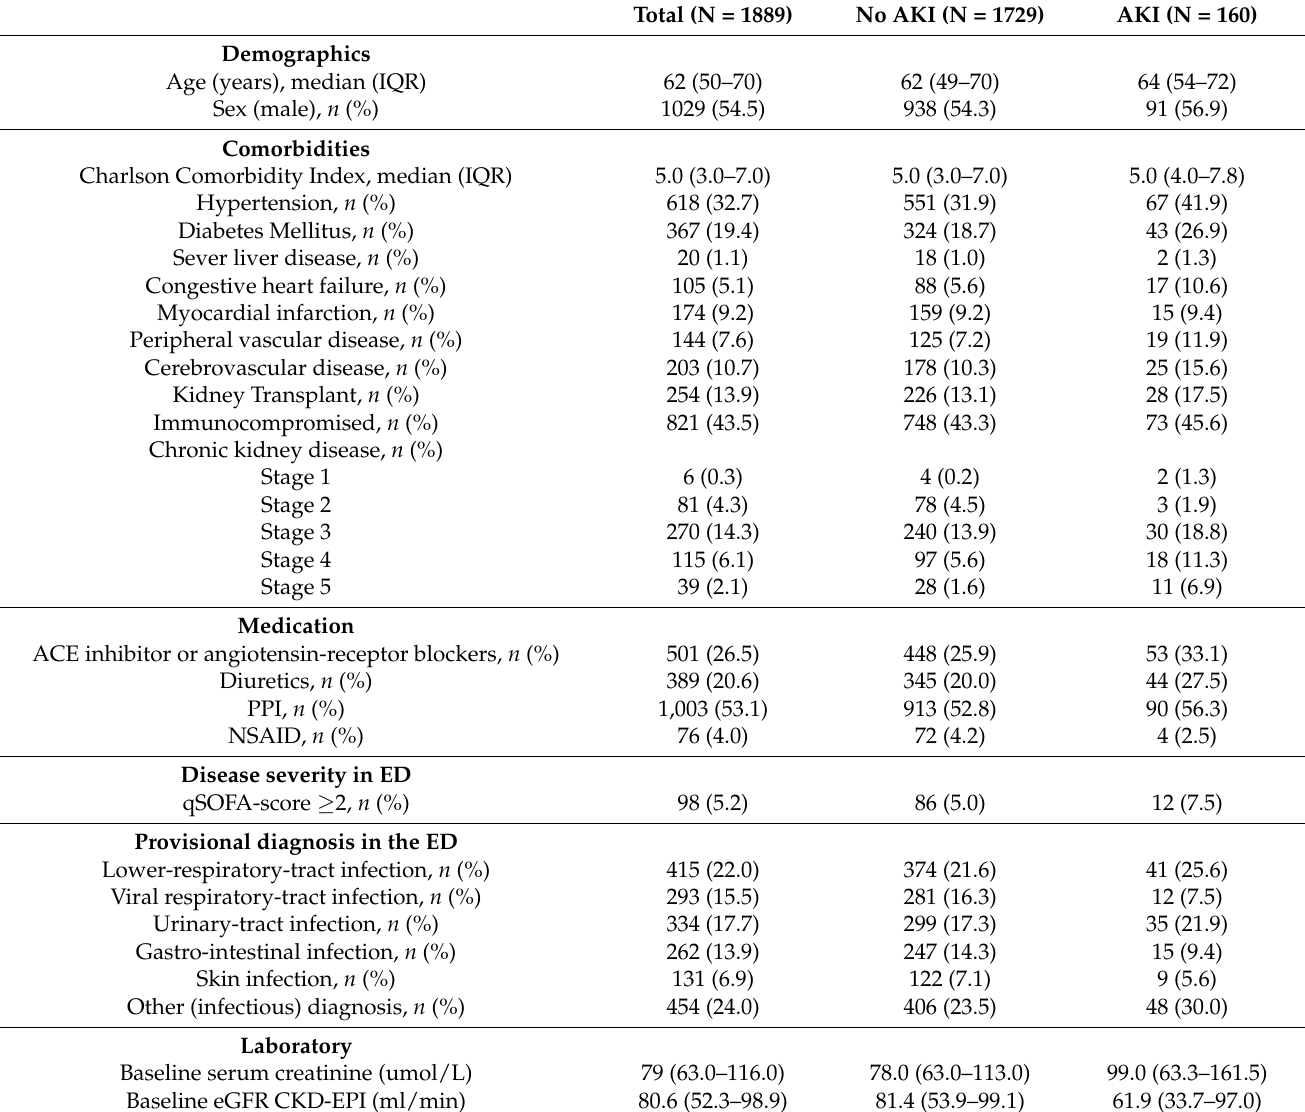
Table 1. Baseline characteristics of study population at emergency department by AKI status.